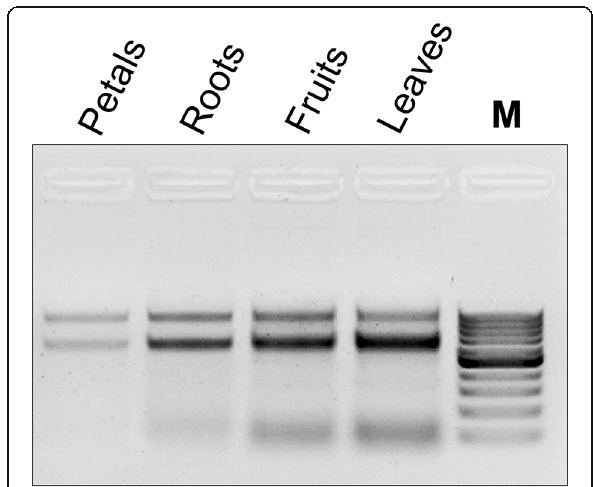
Fig. 3 Total RNA isolation from leaves, fruits, roots, and petals of strawberry plants using double-lysis method. M Gene Ruler TM 100 bp DNA marker